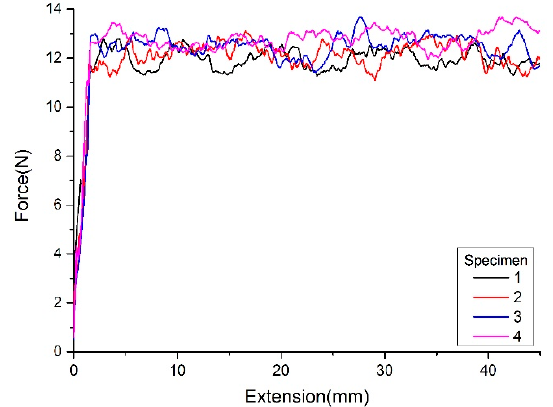
Figure 14. Peeling force with calculated compaction force. Table 4. The average peeling forces.